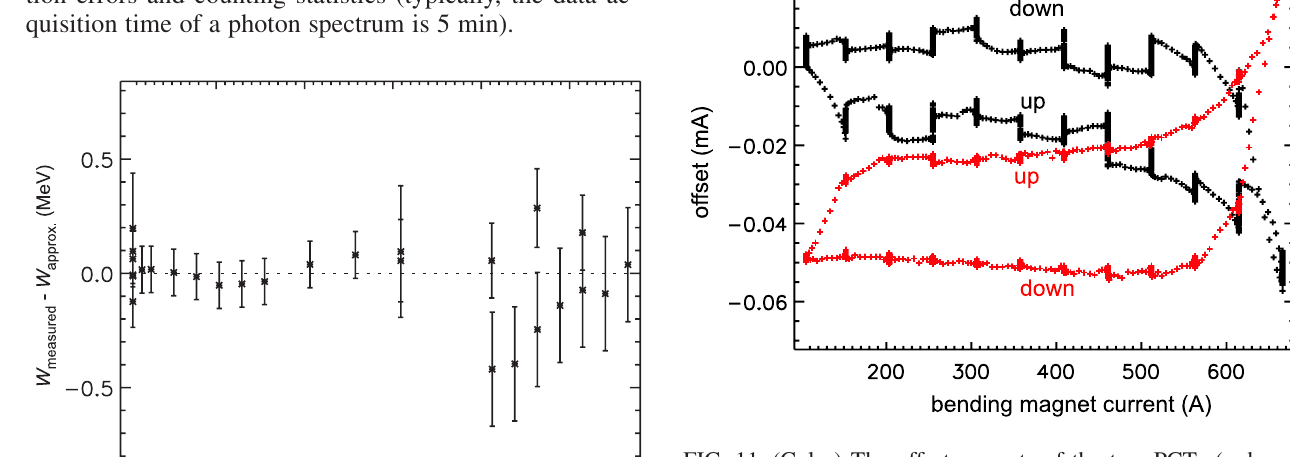
FIG. 11. (Color) The offset currents of the two PCTs (red and black curves) recorded during the increase (up) and decrease (down) of the bending magnet current. The bending magnet current was kept constant at certain values for some time. this results in vertically stacked measurement points of the offset